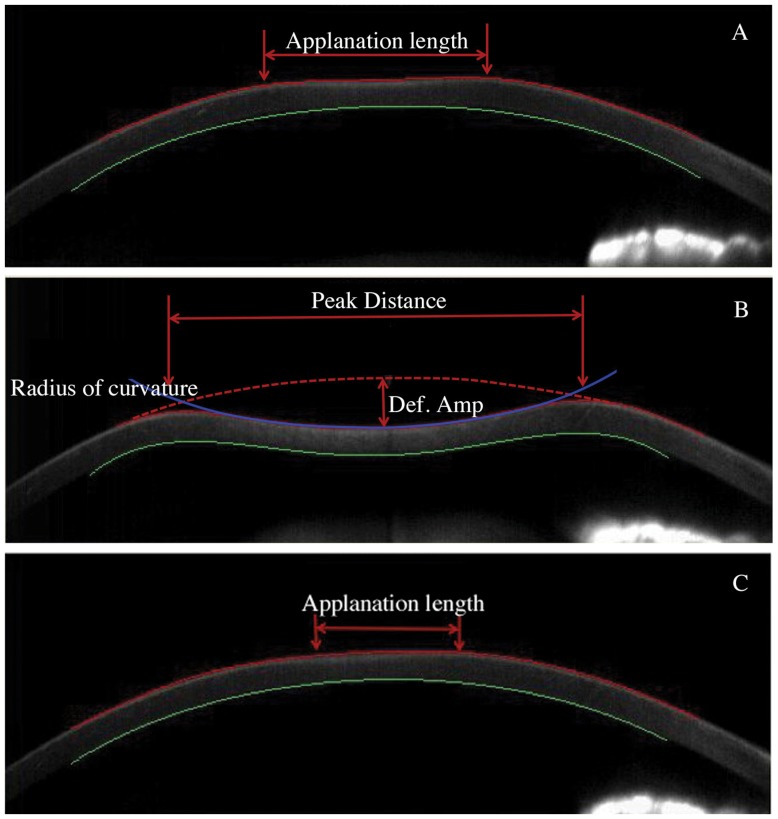
The CorVis ST utilizes the Scheimpflug camera to record the dynamic procedure of the corneal response to an air puff.A) The 1st applanation is achieved. B) The cornea reaches its highest concavity. C) The 2nd applanation is achieved when the cornea rebounds to its original position from the highest concavity.